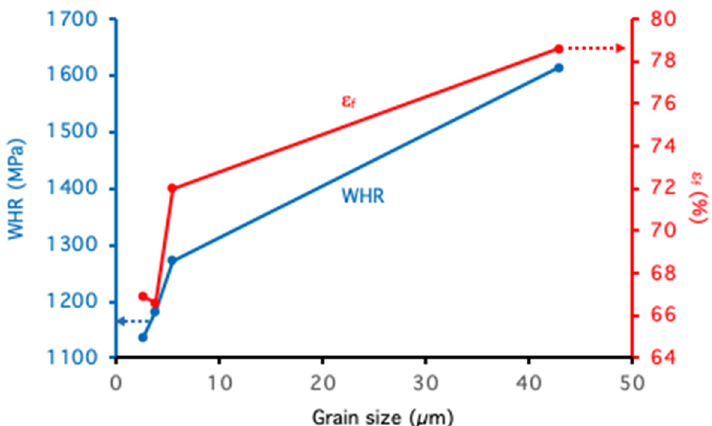
Figure 6. Work Hardening rate (WHR) and percent elongation to failure ( ε f ) for NiCoCr MEA containing 0.47 at. % N. Data based on Table 2 in Moravcik et al.